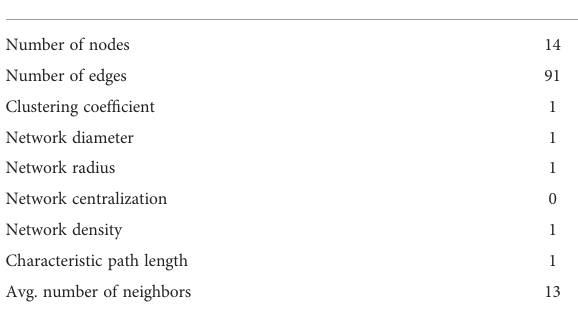
TABLE 1 The network